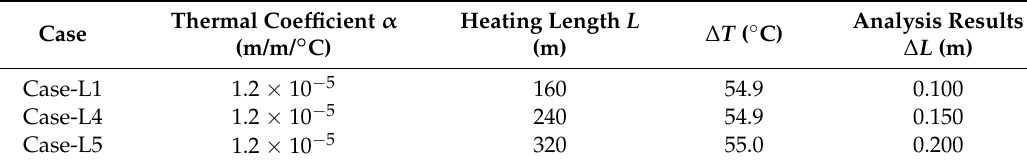
Figure 11. Heating regions for various elongation lengths. Table 8. Temperature rises and heating lengths for various elongation